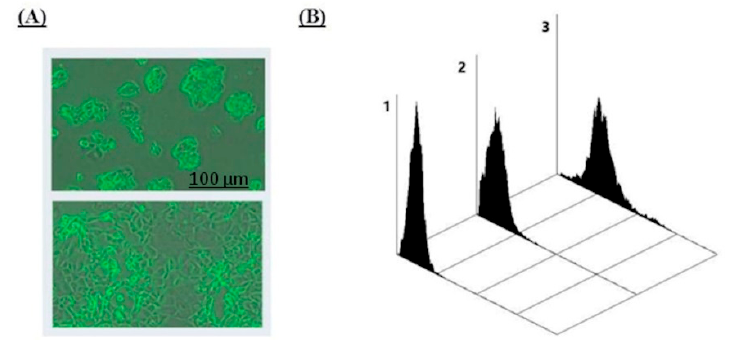
Figure 3. ( A ) Morphology of ZR 75-1 cells grown to 50% (top) and 85% (bottom) monolayer density. ( B ) Interaction of human antibodies affinity-isolated using Le C -Sepharose with ZR 75-1 cells, flow cytometry data (Cytomics FC 500 Beckman Coulter). The concentration of anti-Le C antibodies was 5 µg/mL (1 µg per 10 6 cells). Cells detached from a monolayer were immediately analyzed using flow cytometry: zone 1 , control (no anti-Le C Abs, MFI 0.31); zone 2 , binding of anti-Le C Abs to cells of grown to a density of 50% (7% of cells are positive, MFI 0.34); zone 3 , binding to cells grown to a density of 85% (81% of cells are positive, MFI 2.3).